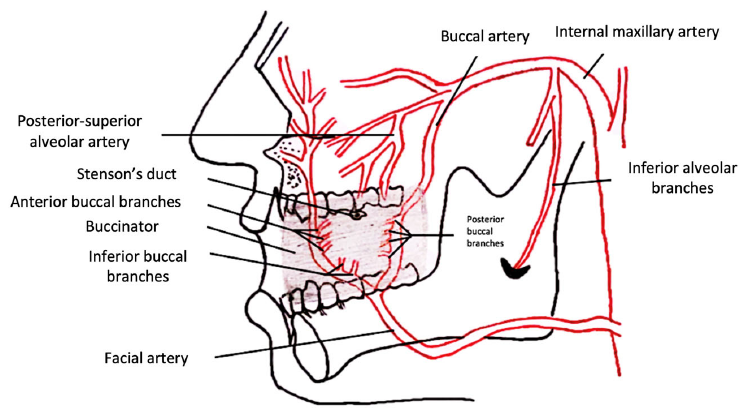
Figure 1. Vascular supply of the buccinator myomucosal flap.